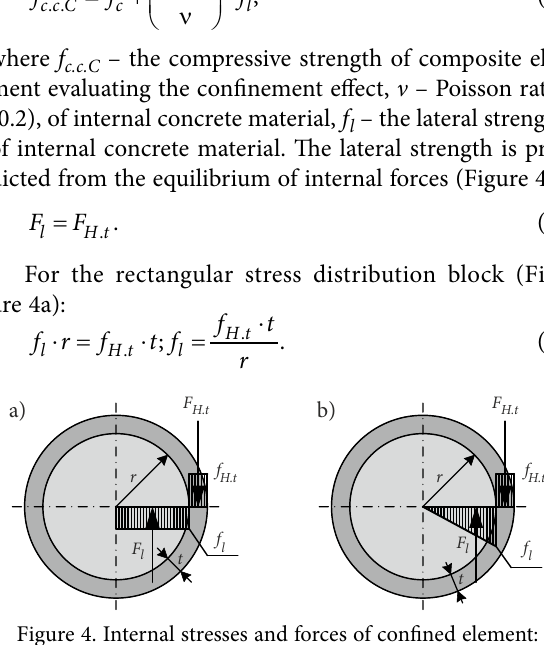
Figure 4. Internal stresses and forces of confined element: (a) – evaluations of rectangular distribution block; (b) – evaluation of triangular distribution